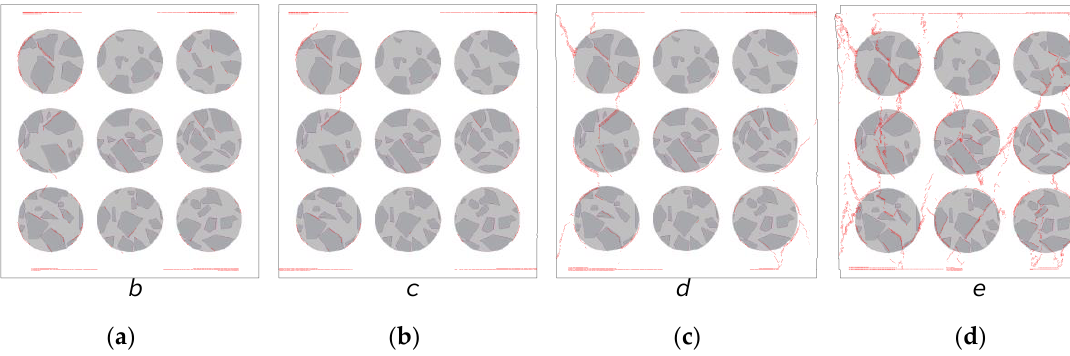
Figure 17. Shear crack distributions at different loading stages from numerical simulation ( a ) loading stage b ; ( b ) loading stage c ; ( c ) loading stage d ; ( d ) loading stage e .